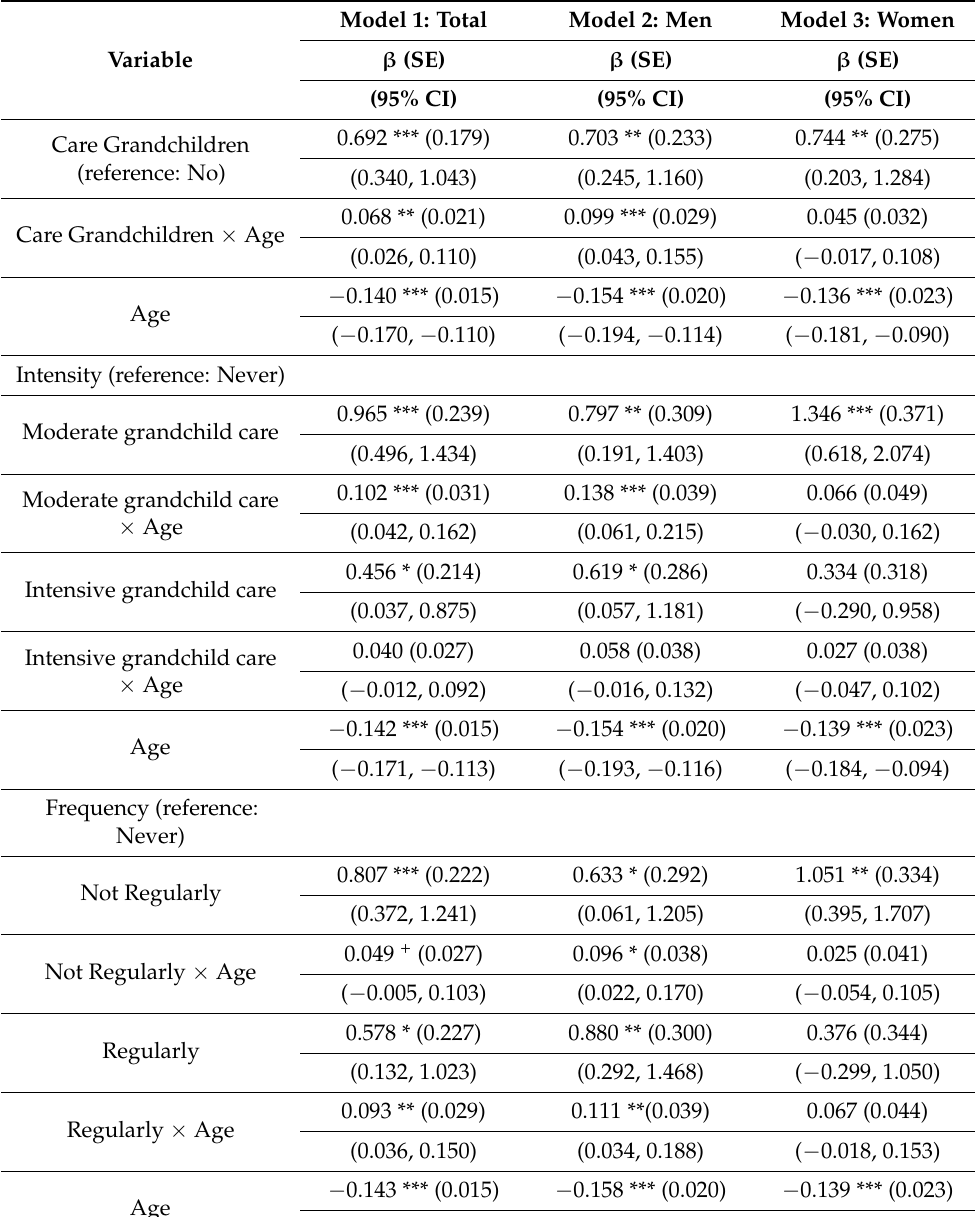
Table 6. Associations between cognition and patterns of grandparent